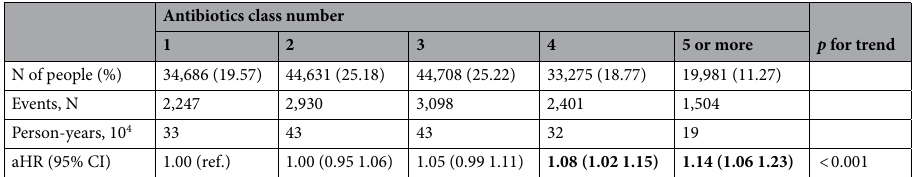
Table 4. Adjusted hazard of diabetes incidence according to the number of antibiotic classes among antibiotics users. N number, aHR adjusted hazard ratio, CI confidence interval, ref. reference. Model Adjusted for age, sex, body mass index, smoking status, days with alcohol drinking per week, physical activity, household income, residence, family history of diabetes, Charlson comorbidity index, fasting blood sugar, total cholesterol, acid suppressants use, and infectious diseases (respiratory diseases, urinary tract infections, skin, soft tissue, bone and joint infections, intra-abdominal infections, and others). The estimates were based on fully adjusted models. Antibiotics were divided into seven classes consisting of penicillin, cephalosporin, macrolide, fluoroquinolone, sulfonamides, tetracyclines, and lincosamides or others. Bold text means statistically significant hazards ratios, where the 95% confidence intervals do not include 1.